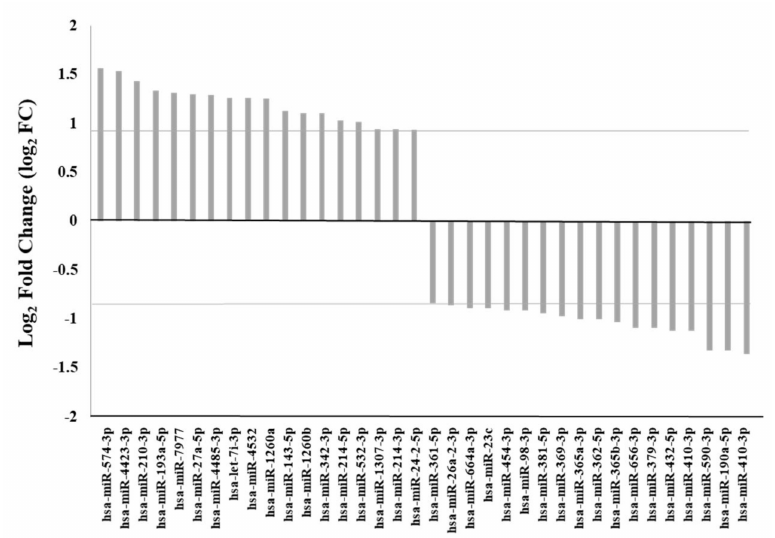
Figure 1. Differentially expressed microRNAs (miRNAs) between MSCs untreated and treated with TGF α . Eighteen miRNAs resulted upregulated in MSCs following treatment with TGF α with a log2 fold change (FC) ≥ 0.93 and 18 downregulated with a log2FC < − 0.83 (Confidence Interval, CI,